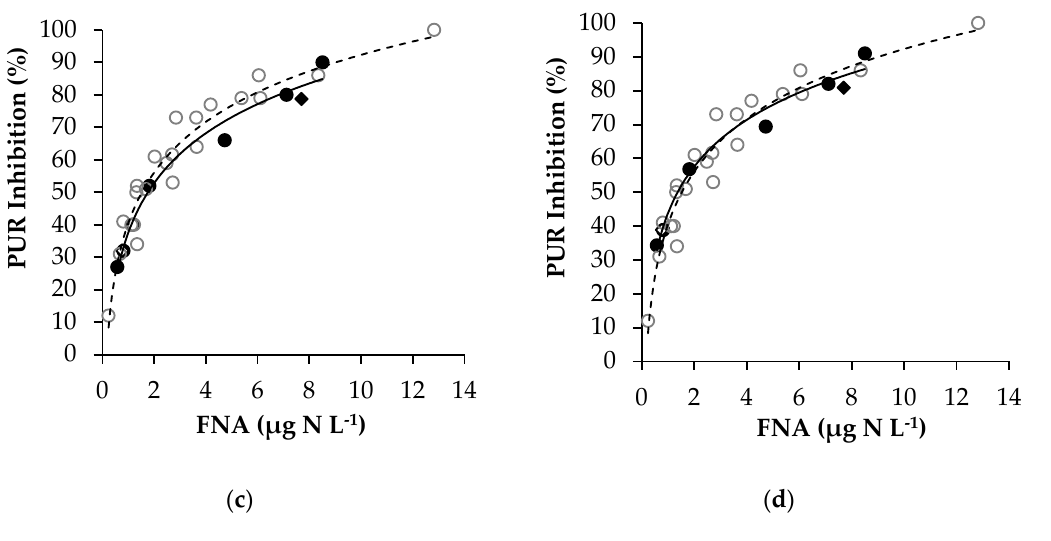
Figure 4. ( a ) The effect of nitrite on the anoxic phosphorus uptake rate (PUR); ( b ) The effect of free nitrous acid (FNA) on anoxic PUR; ( c ) The comparison of anoxic PUR inhibition with aerobic PUR inhibition; ( d ) The comparison of modified anoxic PUR inhibition with aerobic PUR inhibition. ( ● )—anoxic inhibition for first series of experiments (pH = 8), ( ♦ ), ( ◊ )—anoxic inhibition by 30 mg NO 2 ‐ N L − 1 at the pH of 7 and 8, respectively, ( ○ )—aerobic inhibition [7].